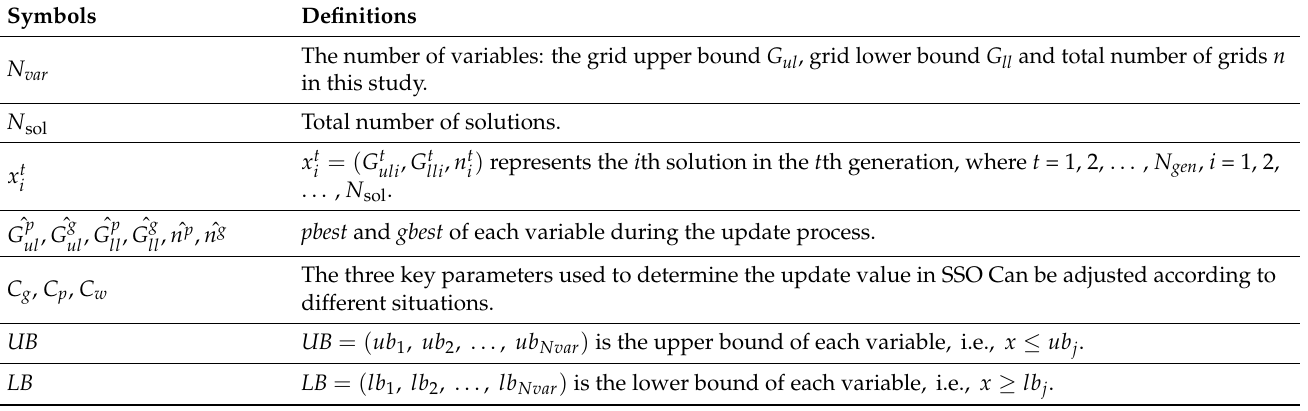
Table 2. Symbols and definitions of